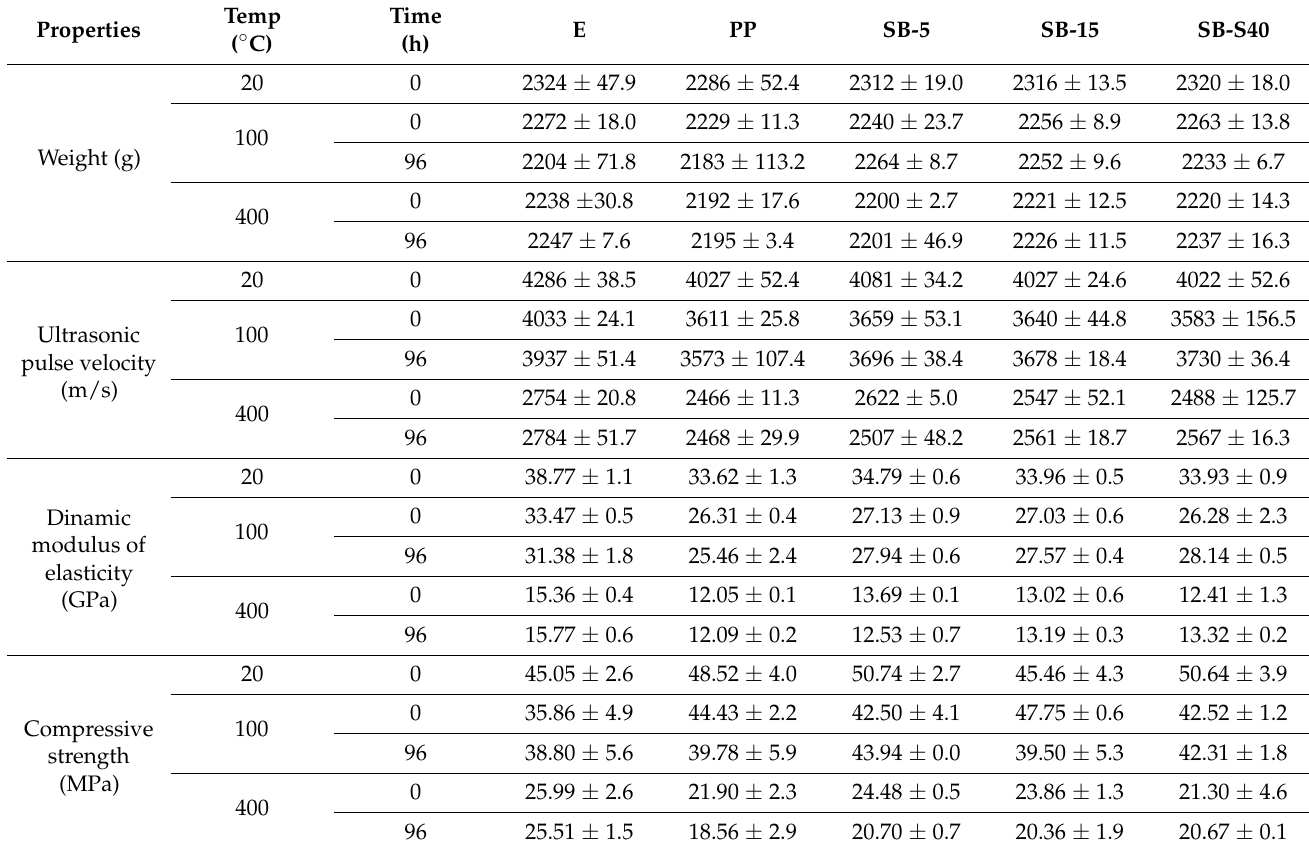
Table 4. Initial and residual values of heated concrete properties with the standard deviation of each